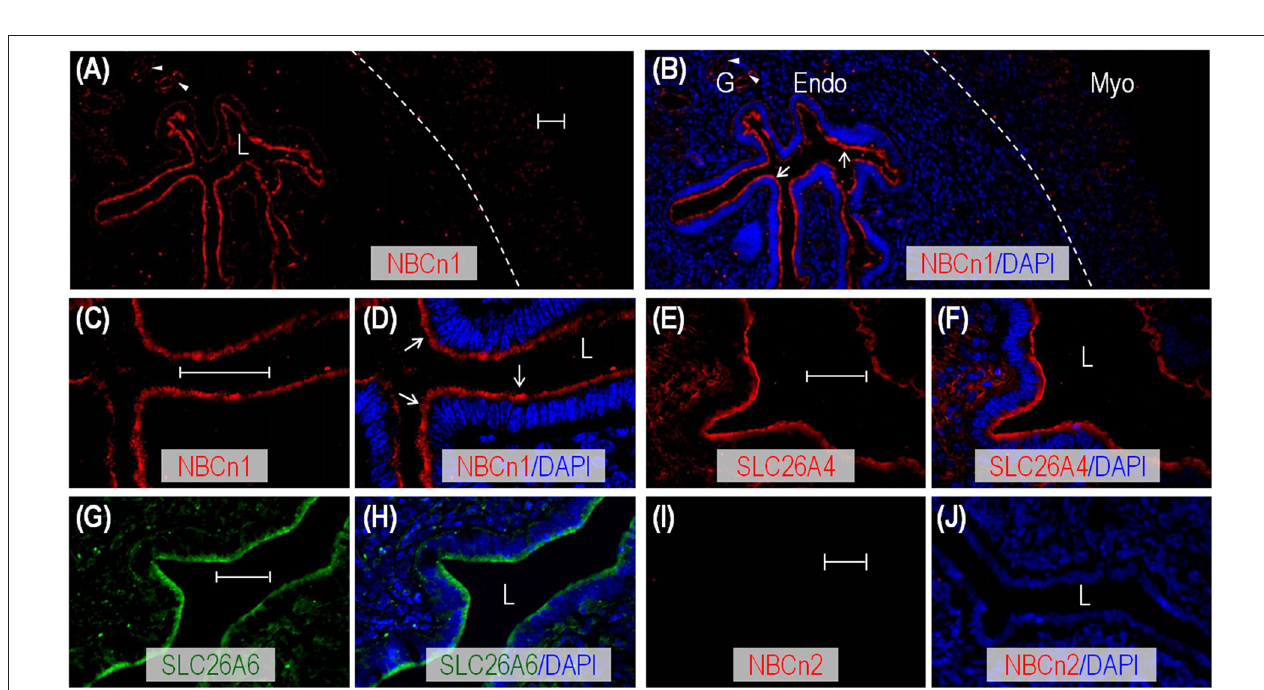
FIGURE 2 | Indirect immunofluorescence of NBCn1, SLC26A4, and SLC26A6 in uterus of adult mouse. (A,B) Overview of NBCn1 expression (A) and its merge with DAPI (B) in a section of mouse uterus. (C,D) High magnification view showing apical localization of NBCn1 in endometrial epithelium in section of mouse uterus. (E,F) Apical localization of SLC26A4 in a section of mouse uterus. (G,H) Apical localization of SLC26A6 in a section of mouse uterus. (I,J) Lack of staining by anti-NBCn2 in section of mouse uterus. In these experiments, the mice were not intentionally examined to determine their estrous stages when sacrificed for uterus collection. The dashed line in B indicates the demarcation between the myometrium layer (Myo) and endometrium layer (Endo). L: uterus lumen; G: glandular duct. Arrows indicate NBCn1 expression at the apical membrane of endometrial epithelium. Arrowheads indicate NBCn1 expression at the apical membrane of glandular epithelium. Scale bars: 40 µ m. Results are representative of 3–4 independent experiments with sections from two different mice.